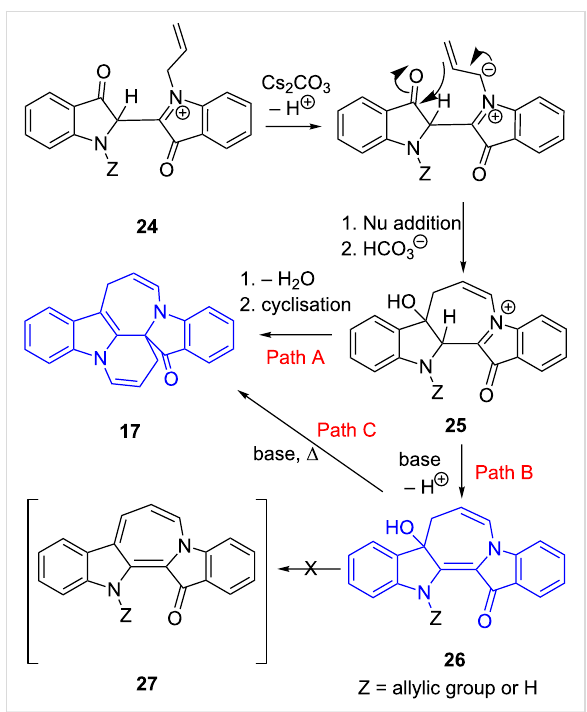
Scheme 6: Proposed mechanism for the synthesis of the red diin- dolone heterocycles and the